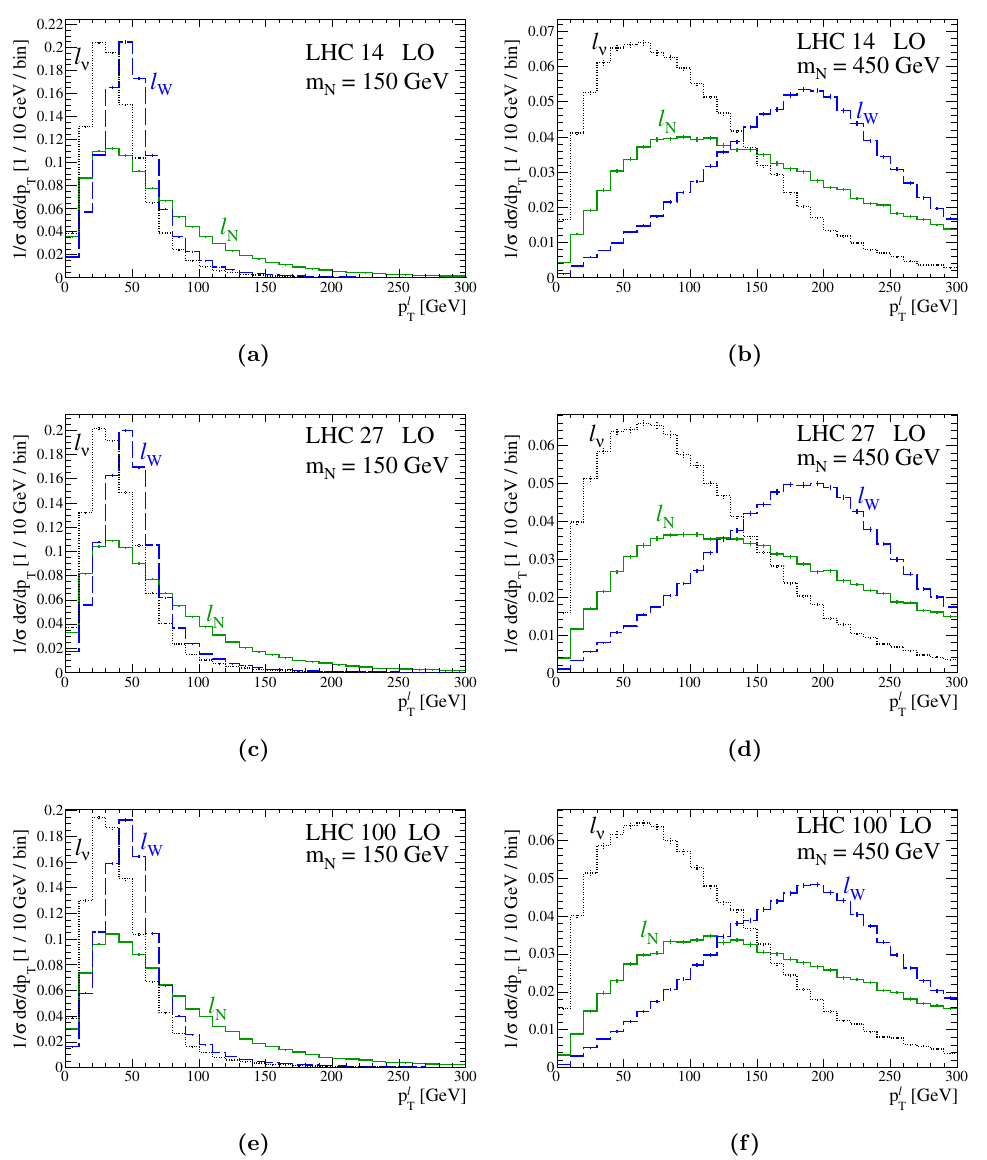
Figure 6. Normalized parton-level transverse momentum ( p T ) distributions for charged leptons produced in the process pp Nl N Wl W l N (cid:23)l (cid:23) l W l N via the DY mechanism at (a,b) p s = 14, ! ! ! (c,d) 27, and (e,f) 100 TeV, for neutrino masses (a,c,e) m N = 150 GeV and (b,d,f) 450